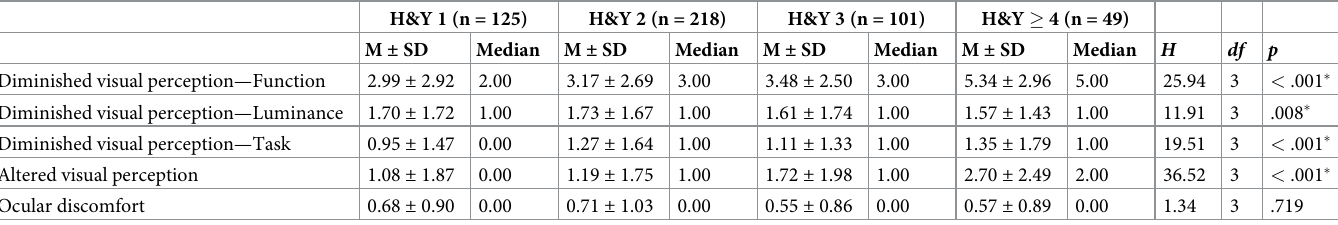
Table 8. Subscale scores of people with PD in different disease severity stages, with Kruskal-Wallis test results.